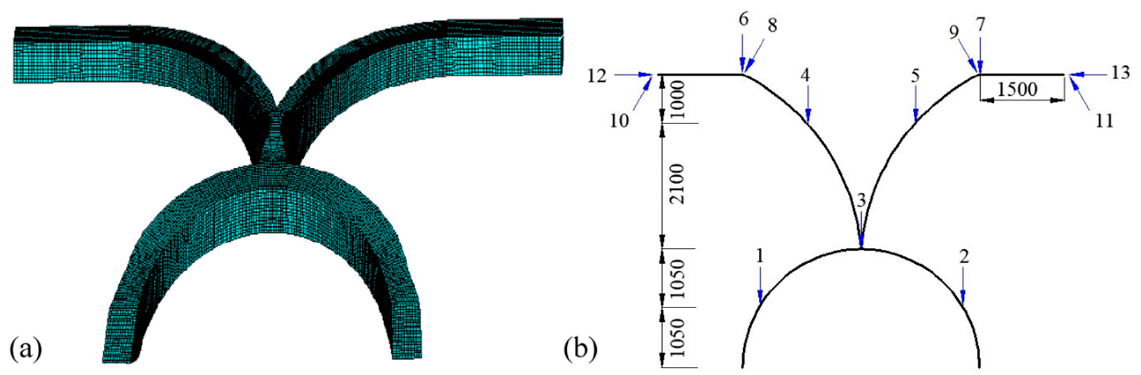
Figure 3. ( a ) Finite element model for the initial model and its corresponding ( b ) loading points and loading directions (units in mm).